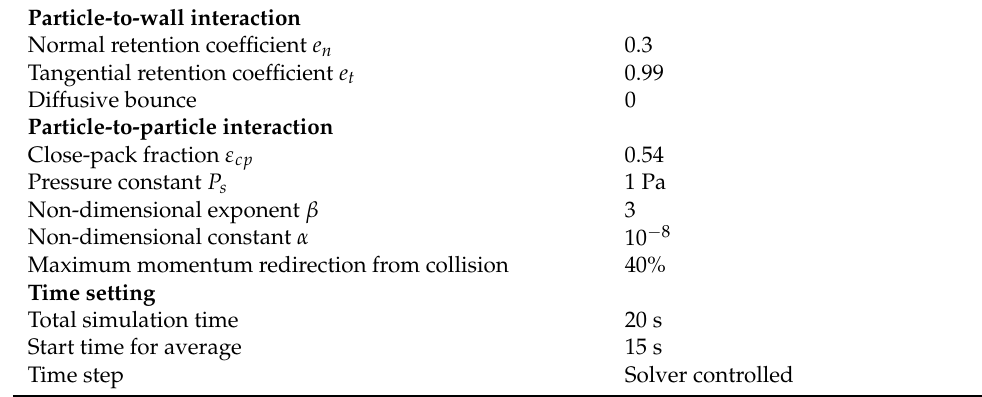
Table 9. Parameters for the simulation of biomass gasification using ilmenite as oxygen carrier.